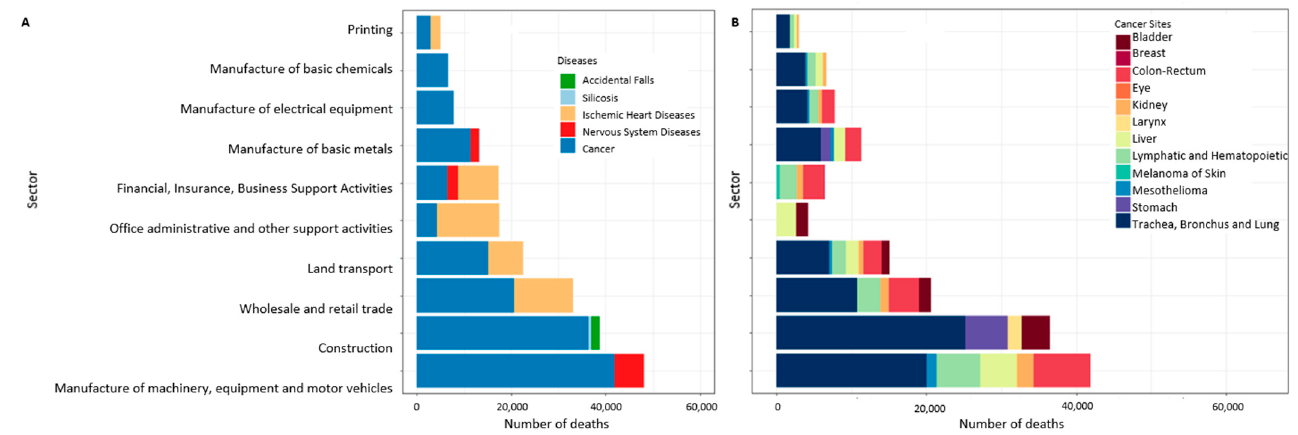
Figure 1. Number of deaths with PMR > 1 by economic sector and diseases or cancer sites in males (( A ) diseases; ( B ) cancer sites). The PMR was calculated considering the longest duration of employment.